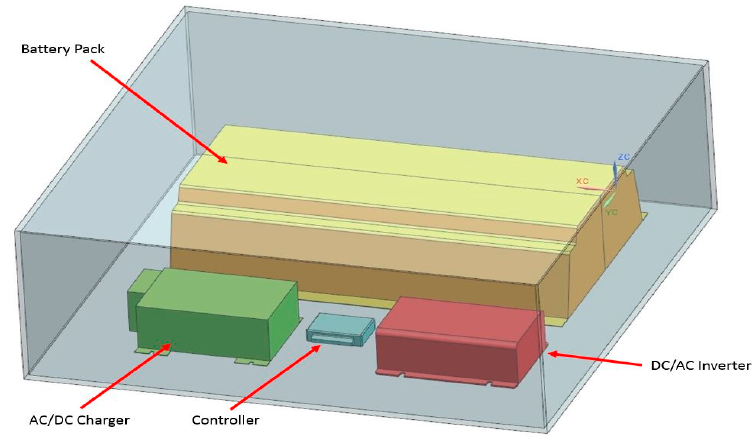
Figure 4. Bench test setup.